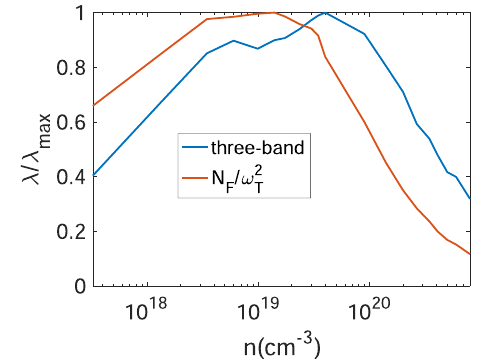
Fig. 2 BCS eigenvalue λ BCS . Comparison between the BCS eigenvalue λ BCS dome in the three-orbital model of Eq. (2) and the single-band model of Eq. (1). In the former, the weak tetragonal crystal fi eld strength of ~2.2 meV 15 has been included, which has little effect around the optimal doping. For a better comparison on the superconducting dome, both lines are rescaled with respect to their maximal value. λ / λ max is the rescaled BCS eigenvalue. Red line is the result from single-band estimation, while blue line is the result from three-band